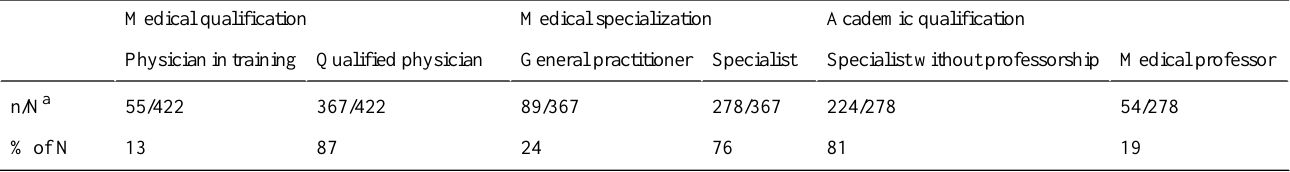
Table 2. Comparisons between different groups of